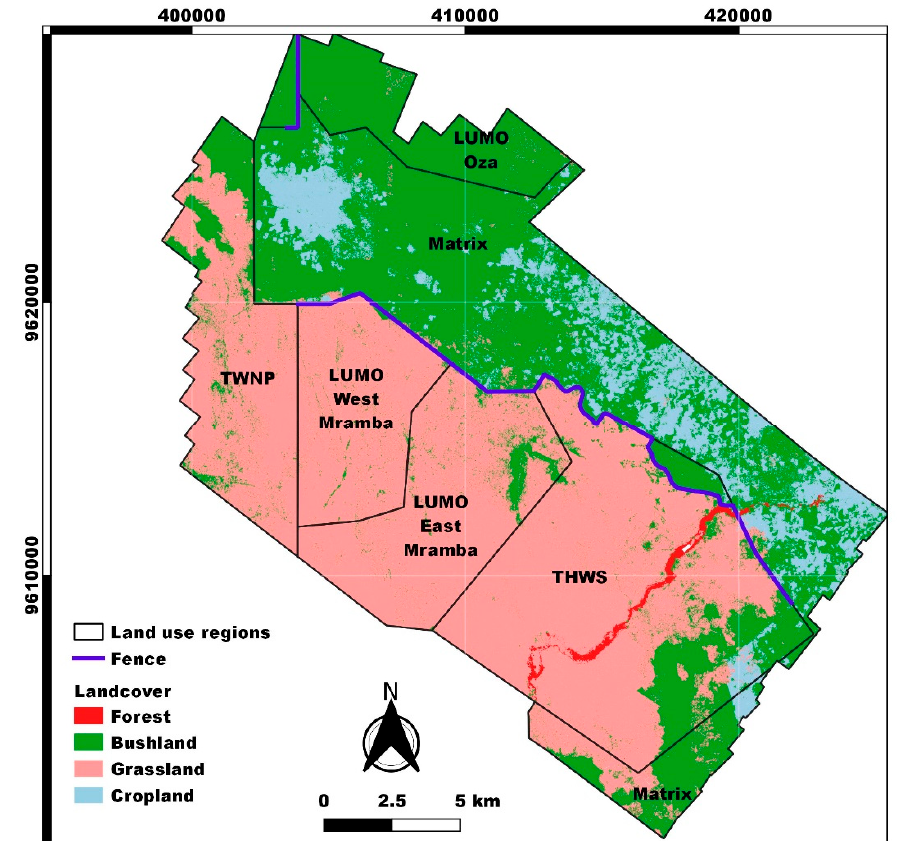
Figure 5. Land cover of the study area showing the boundaries of the land-use regions: Taita Hills Wildlife Sanctuary (THWS), LUMO Community Wildlife Sanctuary (LUMO East Mramba, LUMO West Mramba, and LUMO Oza), Tsavo West National Park (TWNP), and other land use (matrix).